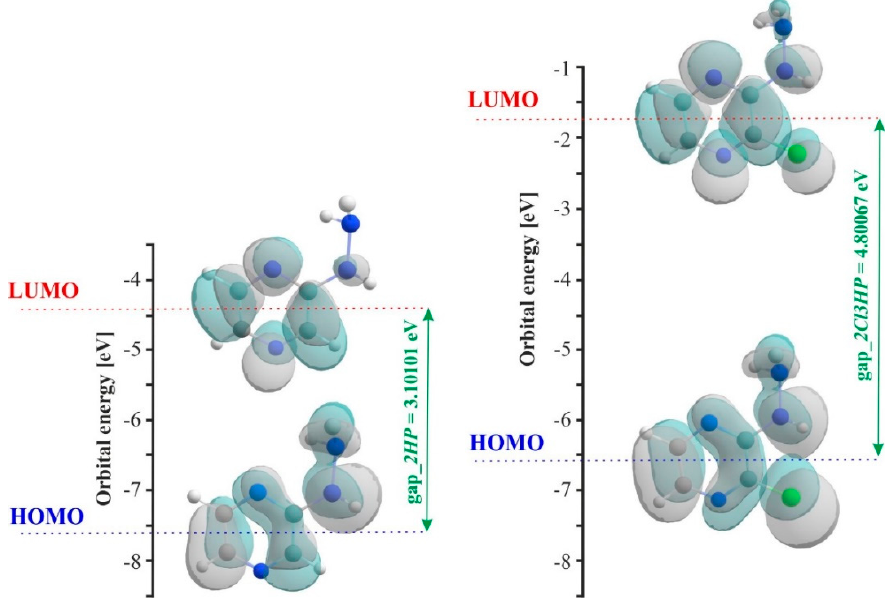
Figure 5. Molecular orbital diagram projected of HOMO − LUMO structures for 2HP and 2Cl3HP calculated at B3LYP/G ‐ 311+G** in vacuo.